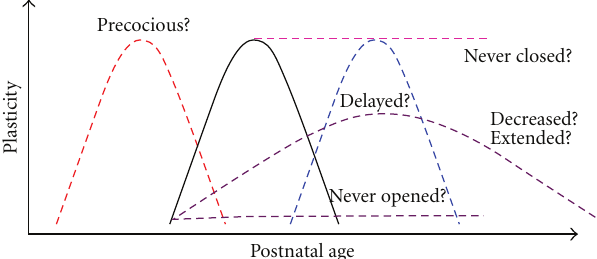
Figure 1: Possible critical period alterations in autism. The solid black curve represents the normal expression of a critical period, with a distinct onset and closure and characteristic duration. Onset could be precocious or delayed. Duration could be increased or decreased. Degree of plasticity could be increased or decreased. Finally, the critical period could fail to open or